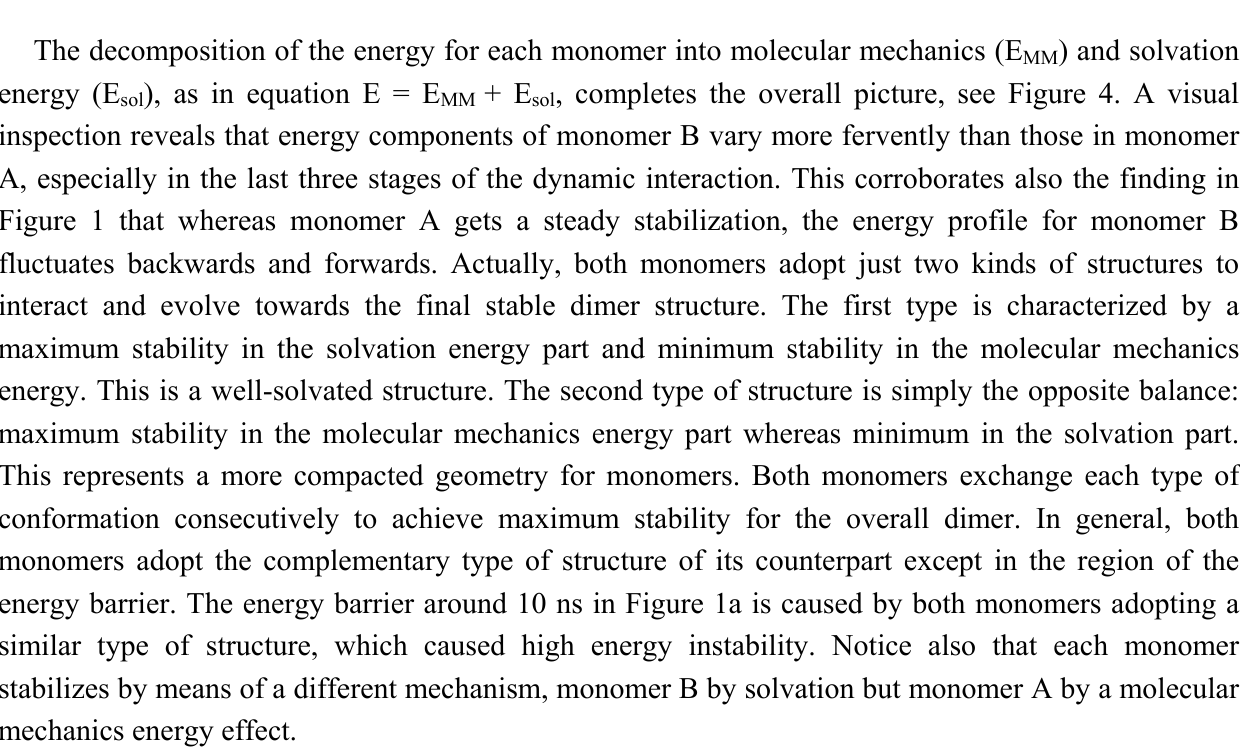
Figure 4. Evolution of the decomposition. (a) E